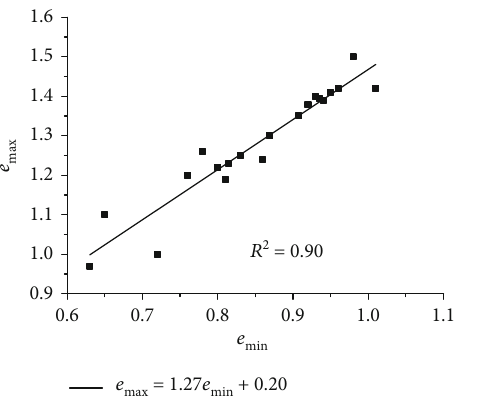
and e max min of calcareous